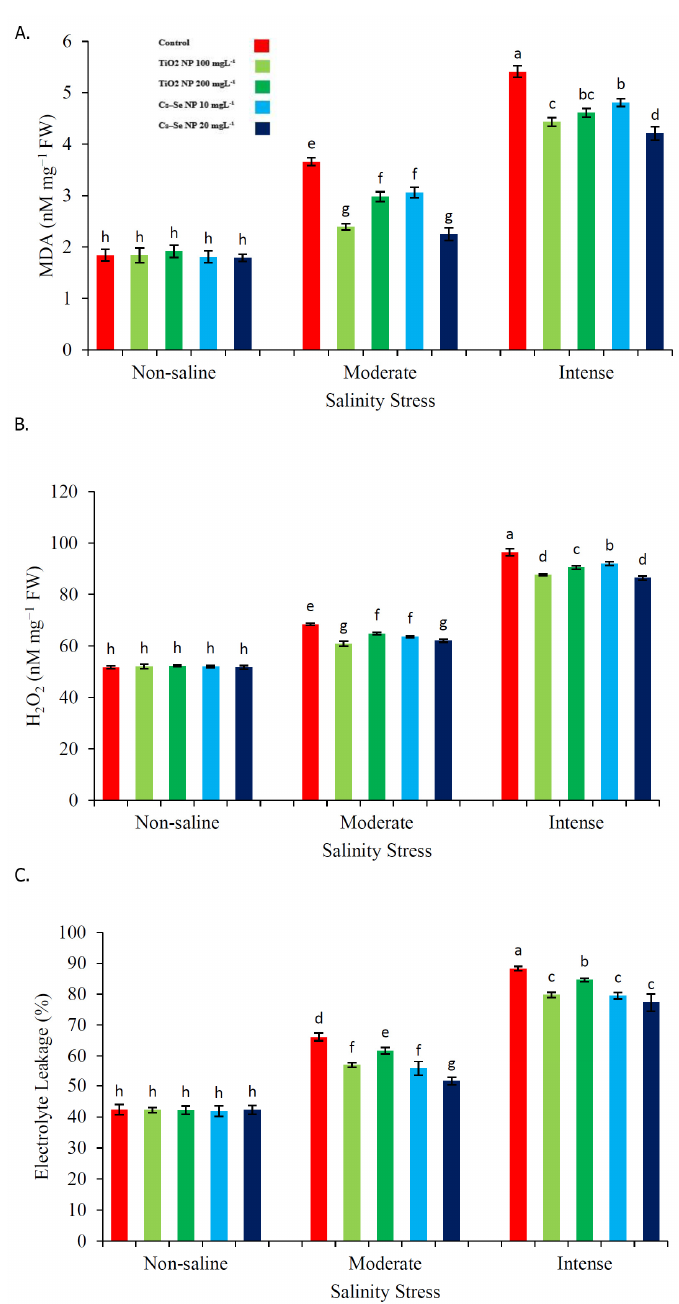
Figure 2. Effect of different concentrations of Cs–Se NPs and TiO 2 NPs on the content of MDA ( A ), H 2 O 2 ( B ) and the electrolyte leakage (%) parameter ( C ) of stevia ( Stevia rebaudiana Bertoni) leaves under salinity stress. Data are the average of 3 repetitions ± standard error. Different letters indicate significantly different values according to Duncan’s post hoc analysis at p <